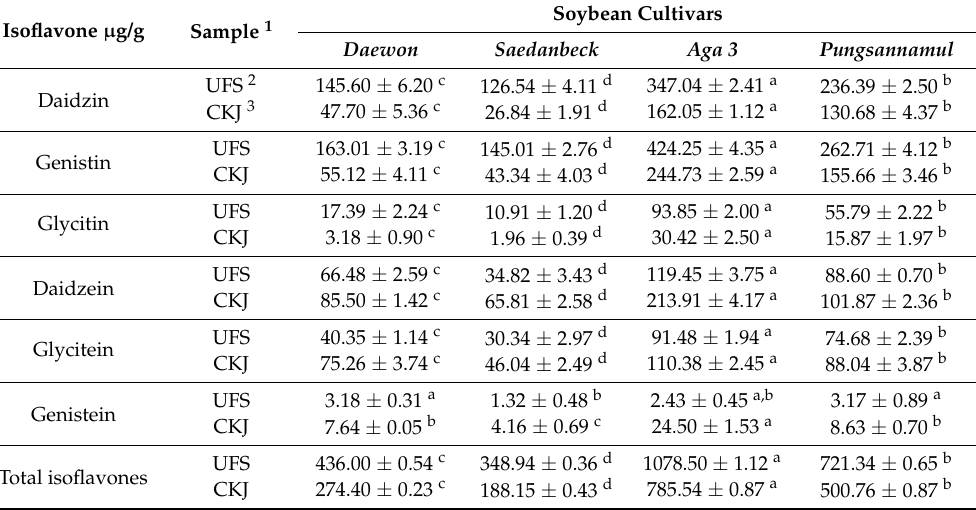
Table 2. Changes in isoflavone contents between unfermented soybeans and cheonggukjang fermented by Bacillus subtilis (KCTC 13241) in different soybean